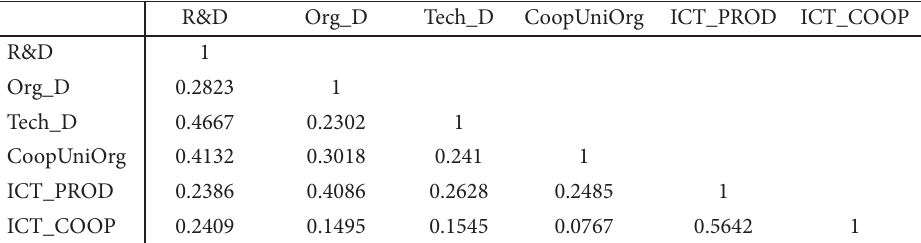
Table A2. Tetrachoric correlations for binary variables